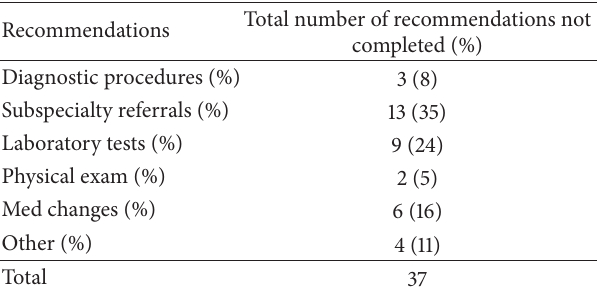
Table 3: Types of recommendations not pursued by 6 months following hospital